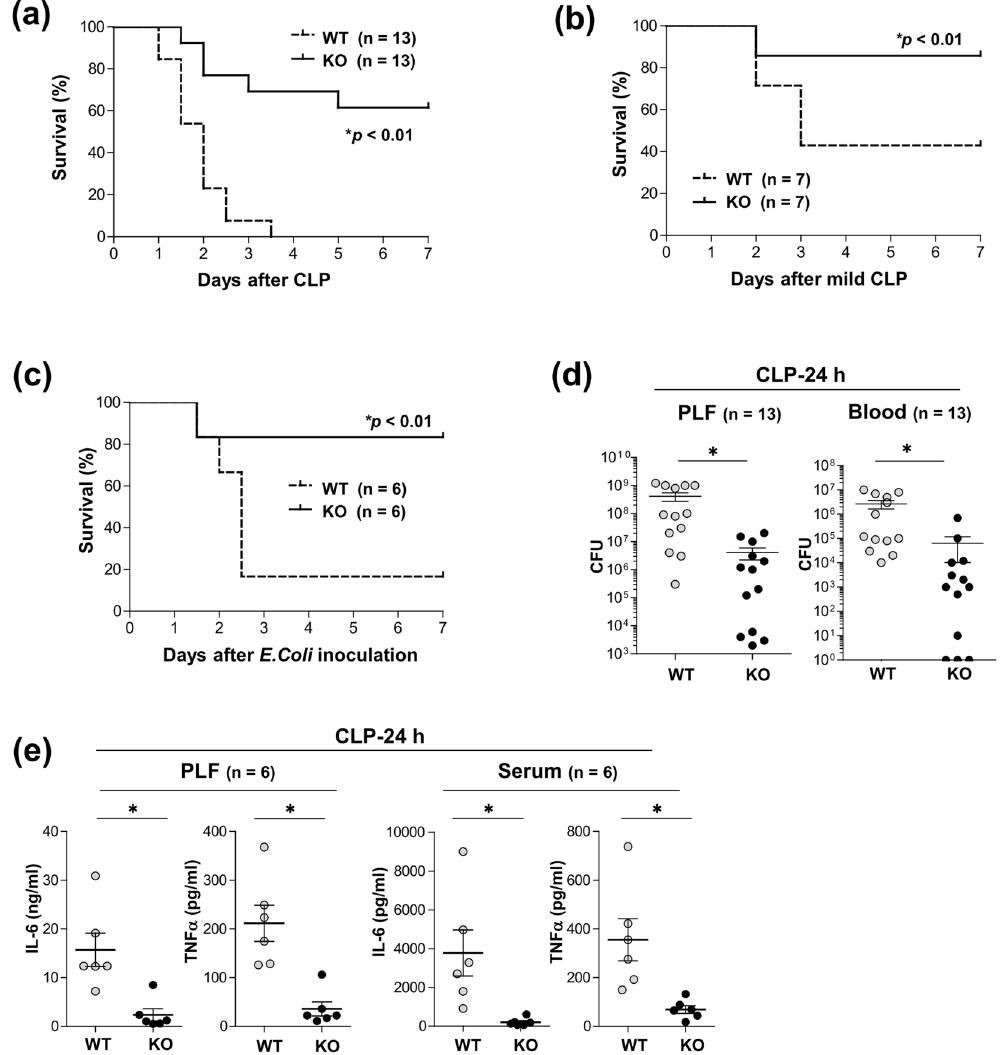
Figure 1. CD300f − / − mice were highly resistant to CLP-induced sepsis. ( a , b ) WT or CD300f − / − mice were subjected to ( a ) CLP (n = 13 per genotype) or ( b ) mild CLP (n = 7 per genotype), and monitored regarding survival. ( c ) WT or CD300f − / − mice (n = 6 per genotype) were intraperitoneally inoculated with a suspension of E. coli (4.0 × 10 8 colony-forming units [CFU] per mouse) and monitored regarding survival. ( a – d ) * p < 0.01 (log-rank test). ( d ) Bacterial counts (CFUs) in PLF or PB of WT or CD300f − / − mice 24 h after CLP (n = 13 per genotype). ( e ) The concentrations of IL-6 or TNF- α in PLF or serum of WT or CD300f − / − mice 24 h after CLP (n = 6 per genotype). ( d , e ) The data are expressed as mean ± SD; * p < 0.01 (Student’s t -test). ( a , b , c and e ) The data are representative of two independent experiments. WT and KO indicate WT mice and CD300f − / − mice,